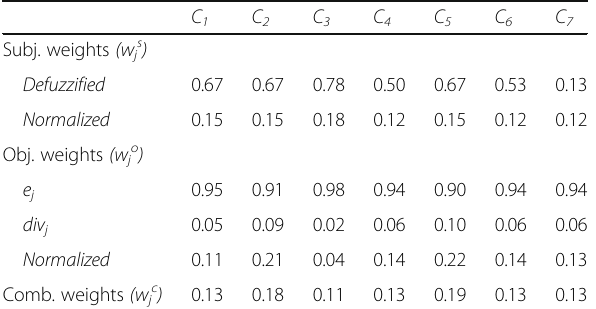
Table 4 Combination weights of